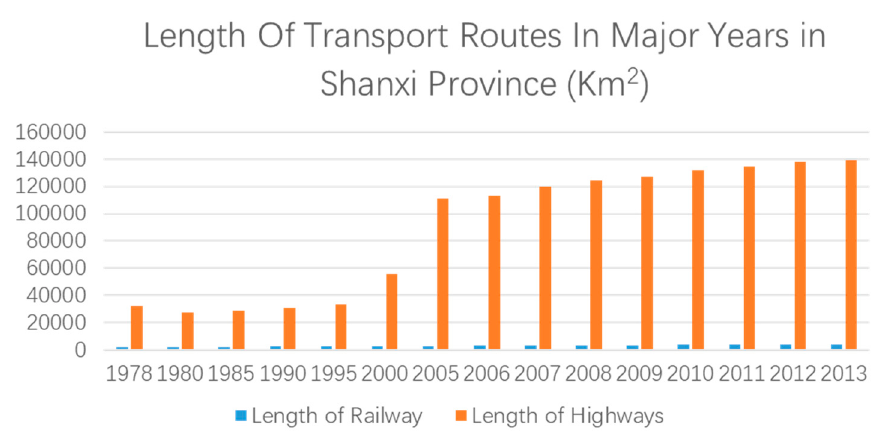
Figure 10. Number of households.